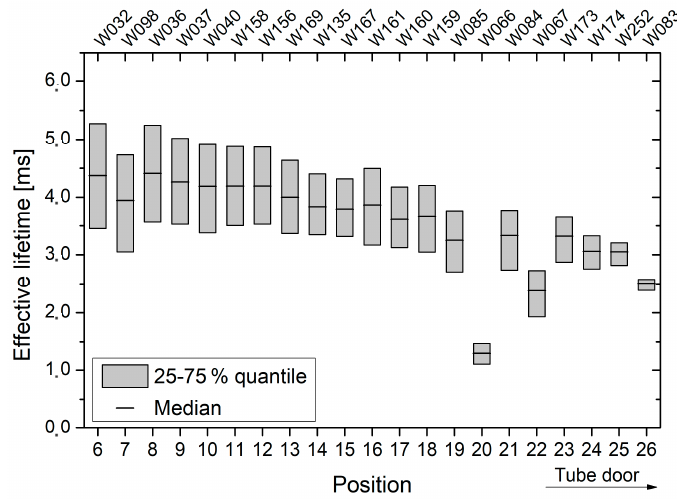
Figure 7. For oxidation run δ , effective lifetimes are shown as a function of the quartz boat position and wafer number, respectively. The quartz boat positions 6–26 contained only 100 mm wafers from batch C, whereby quartz boat position 26 is located in direction of the tube door.